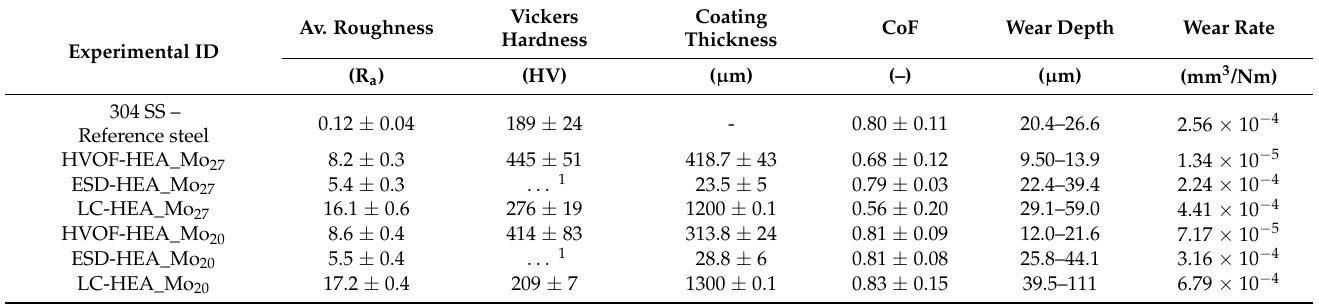
Table 6. Summary table of the surface characterization results obtained for each HEAC deposited with the different coating techniques and results from the hardness and dry sliding wear